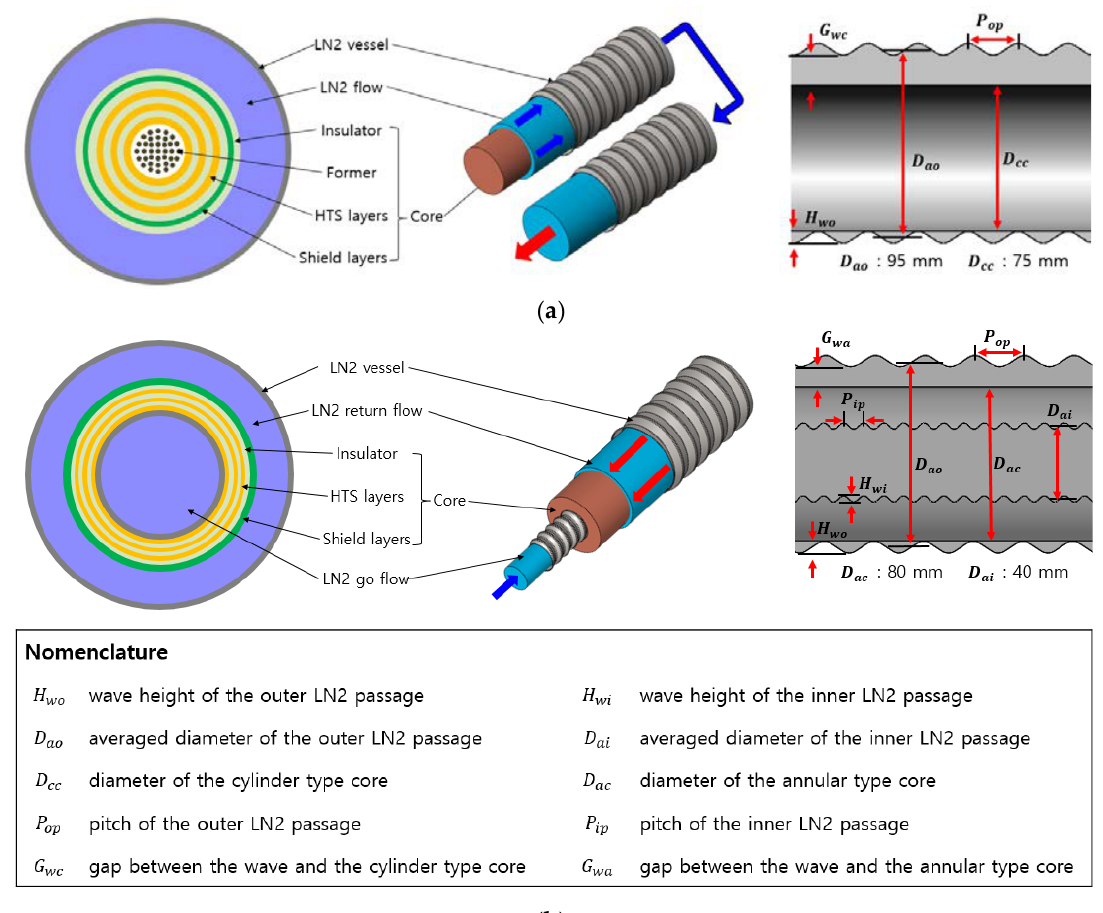
Figure 1. Structure of the triaxial HTS power cable with: ( a ) an external return path; ( b ) an internal return path.